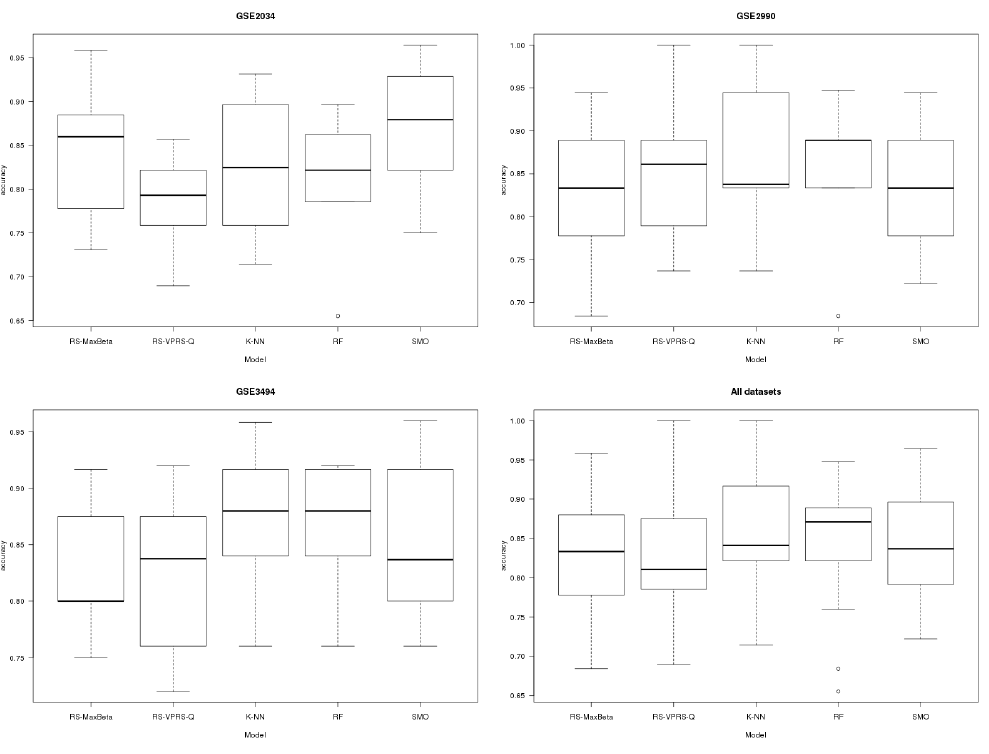
Figure 2: Comparison of the models accuracy in each dataset and in all datasets